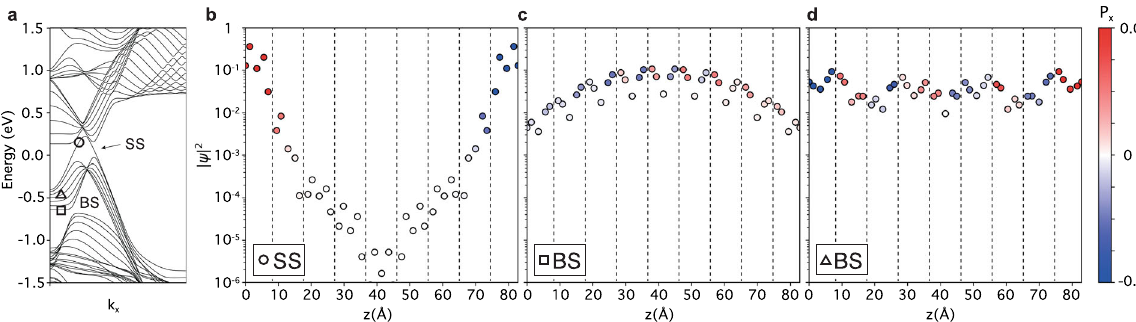
Fig. 7 Layer-dependent spin polarization. a Calculated band structure along the dashed line of Fig. 3b, plotted for positive wave vectors k x . b Probability density (logarithmic scale) calculated within each quintuple layer of a 9-unit cells slab and plotted as a function of the z axis, for the surface state indicated by a circle in panel a . The color of the symbols encodes the local spin polarization P x , whose magnitude is indicated by the blue-white-red color scale. Dashed lines separate different unit cells. c and d Same as in panel b for the bulk states indicated by a square and a triangle in panel a .